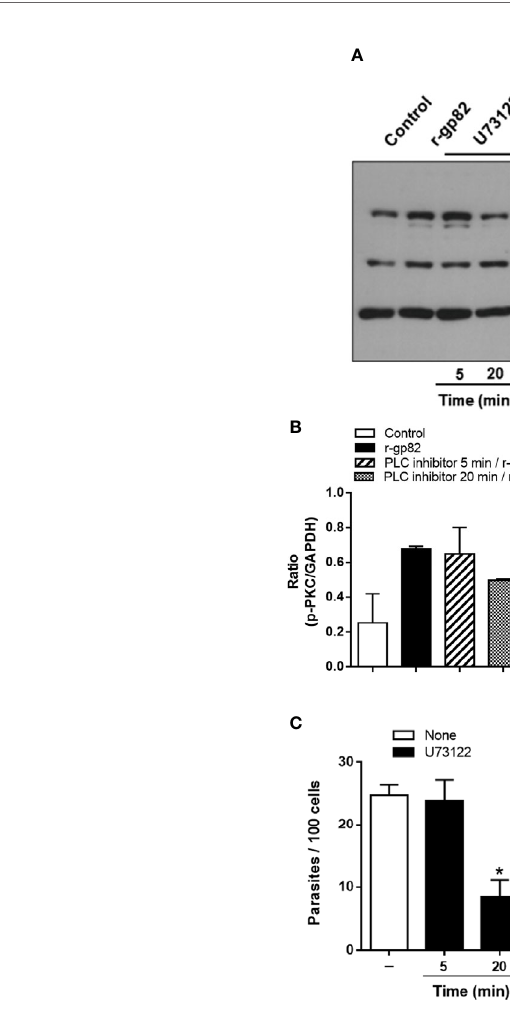
FIGURE 7 | Blockage of gp82-induced activation of host cell PKC by PLC inhibitor. (A) HeLa cells, untreated or pretreated with PLC inhibitor, for the indicated time, were incubated for 30 min in absence or in the presence of r-gp82, and analyzed by western blotting for detection of phosphorylated PKC. Note that treatment of cells with PLC inhibitor for 20 min impaired the gp82-induced activation of PKC. (B) The ratio of p-PKC/GAPDH is shown. Values are the means ± of two assays. (C) HeLa cells, untreated or pretreated with PLC inhibitor for the indicated time, were incubated for 1 h with MT, and the internalized parasites was quanti fi ed. Values are the means ± SD of fi ve independent assays performed in duplicate. MT internalization was signi fi cantly inhibited in cells pretreated with PLC inhibitor for 20 min (* P < 0.0001). (D) HeLa cells, untreated or pretreated with U73122 for 20 min, were incubated with r-gp82 for 30 min and processed for immuno fl uorescence microscopy. The cortical F-actin structure and the lysosome localization were similar in untreated control and in cells pretreated with U73122 min and incubated with